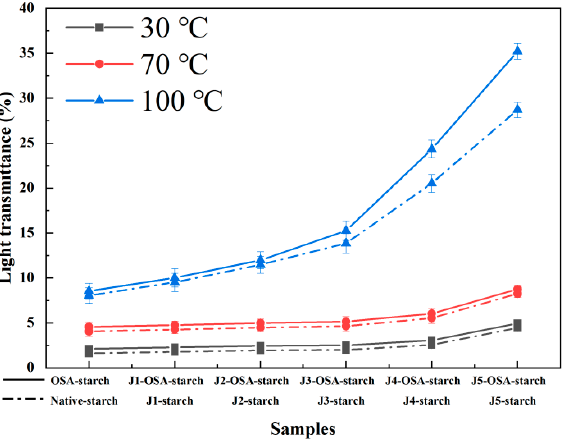
Figure 7. Transparency of the treated corn starch samples.